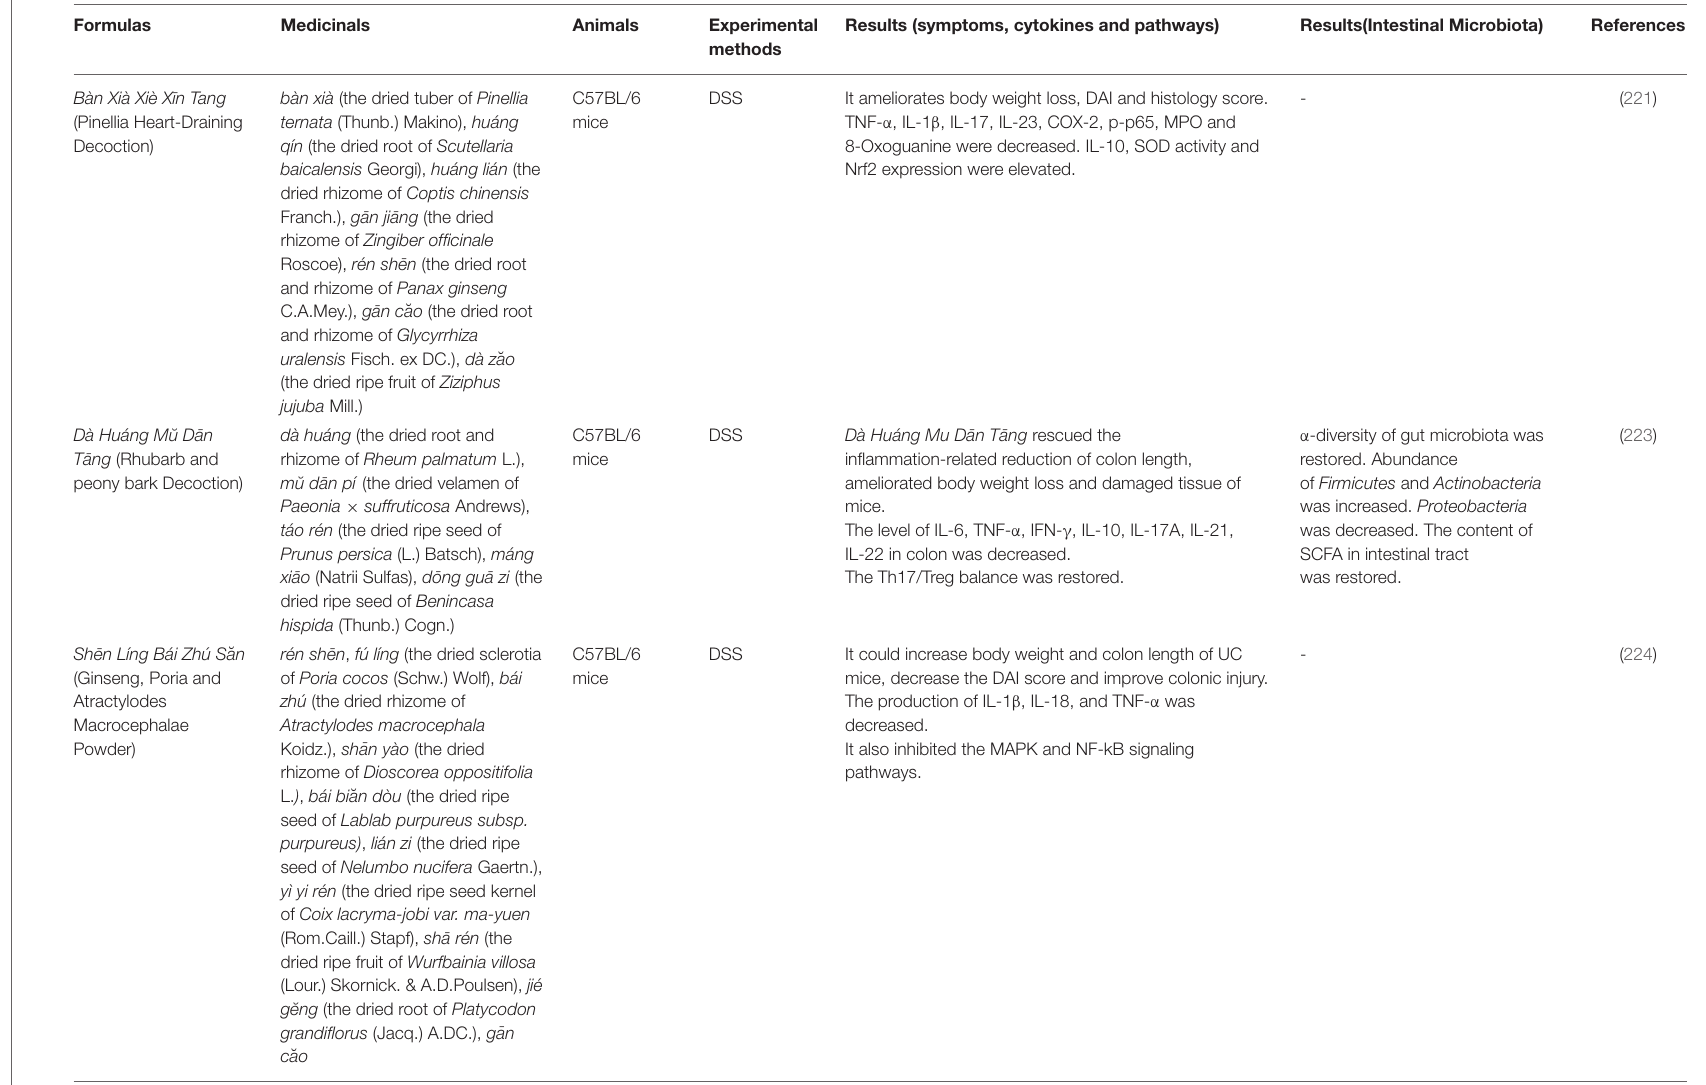
TABLE 7 | Application of Chinese medicinal formulas in animal models of